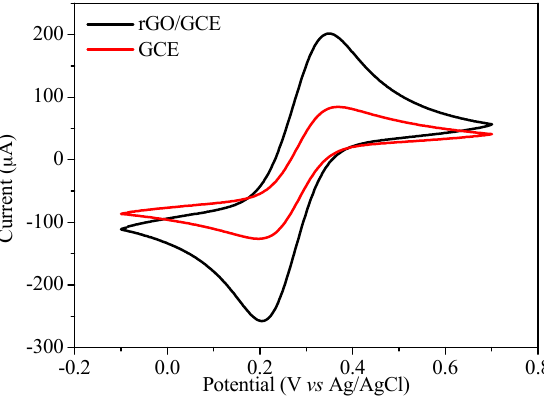
Figure 1. Voltammetric profile of the ferri-ferrocyanide couple at 20 mmol L − 1 using GCE and the rGO/GCE electrode with a 0.10 V s − 1 scan rate.